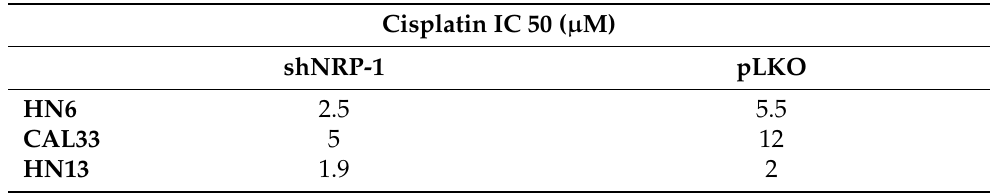
Table 2. 50% inhibitory concentration values (IC50) calculated for HN6, CAL33, and HN13 cell